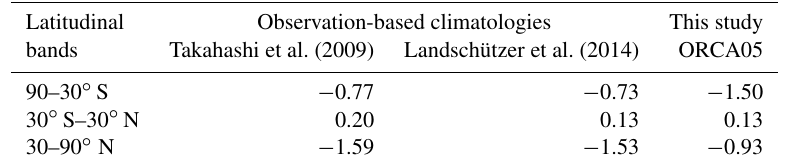
A comparison of the simulated vs. observed F CO mates for each MARCATS region is reported in Table 2 and Fig. 6. The Pearson correlation coefficient R is 0.8 for spe- cific fluxes. In the model, 79 % of the MARCATS regions act as carbon sinks, whereas that proportion is 64 % for